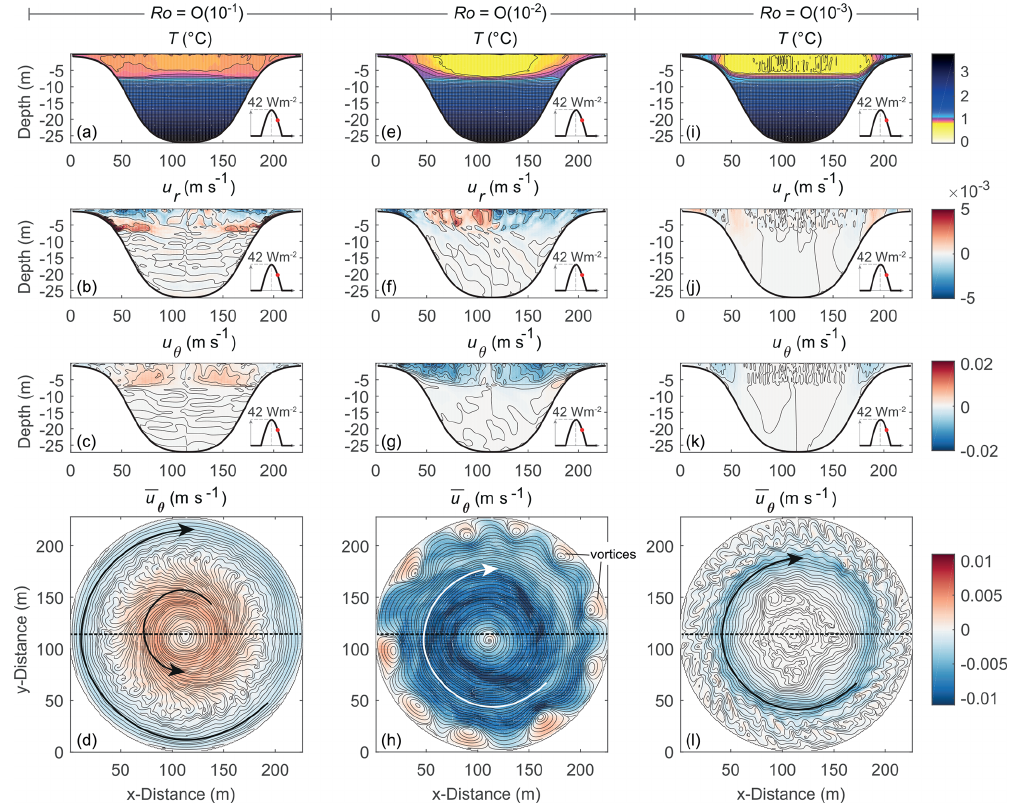
Figure 3. Snapshots of the thermal and velocity structure for different Ro . Snapshots from day 11.6, just after peak insolation, showing the simulated cross-sectional (a, e, i) temperature (0.02 ◦ C isotherm spacing) and (b, f, j) radial and (c, g, k) azimuthal velocities (0.002m s − 1 isovel spacing) and depth-averaged (d, h, l) azimuthal velocities and flow streamlines at depths ≤ h cml . Radial and azimuthal velocities are positive towards the lake interior and for cyclonic circulation, respectively. Black dashed lines in (d, h, l) show the location of the cross section displayed in (a–c) , (e–g) and (i–k) . Results for runs with (a–d) Ro O(10 − 1 ) , (e–h) Ro O(10 − 2 ) and (i–l) Ro O(10 − 3 ) .